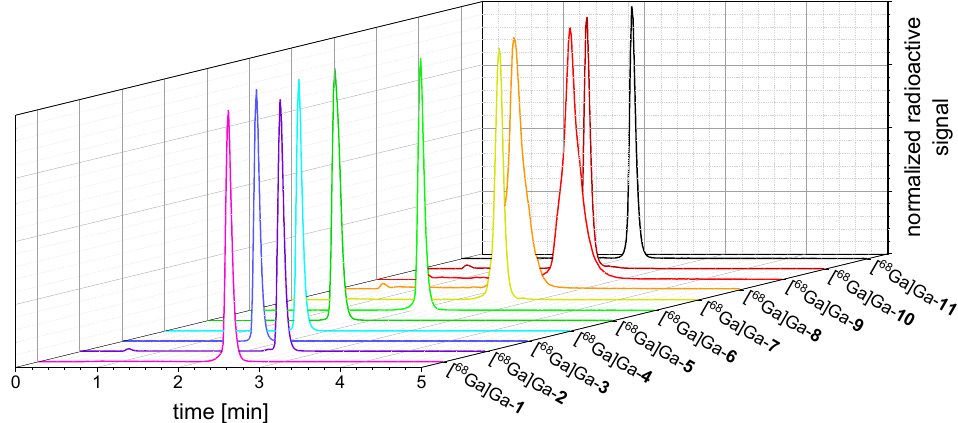
Figure 4. Analytical radio-HPLC chromatograms of [ 68 Ga]Ga- 1 –[ 68 Ga]Ga- 11 as obtained directly after radiolabeling of 1 – 11 with 68 Ga 3+ .